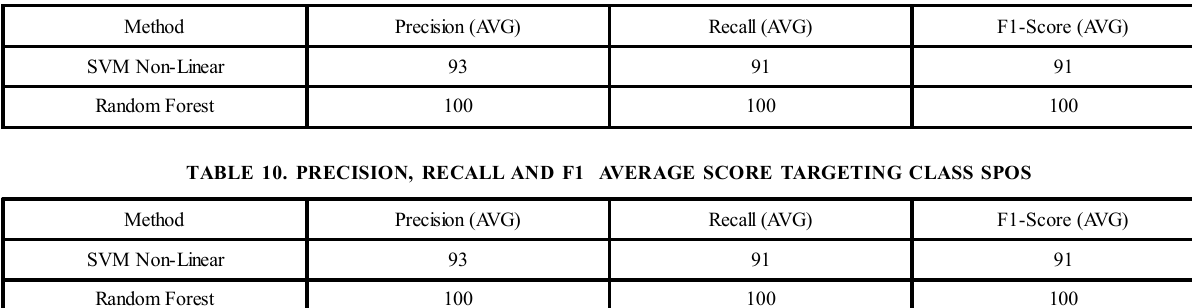
TABLE 9. PRECISION, RECALL AND F1 AVERAGE SCORE TARGETING CLASS UPOS